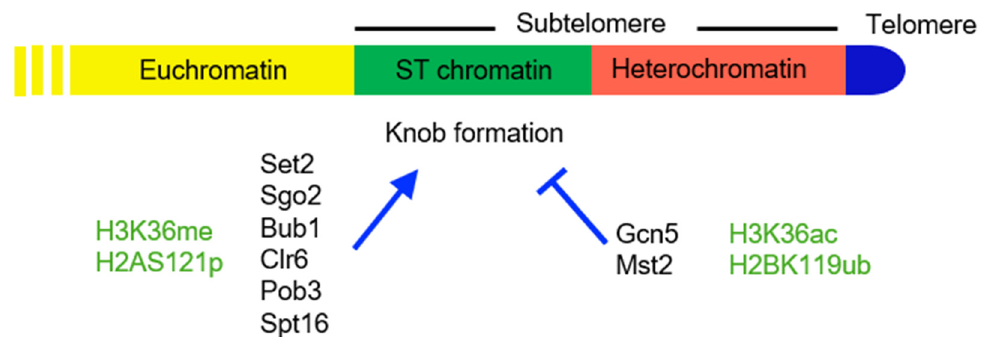
Figure 4. The ST domain in S. pombe. Protein factors (black) and histone modifications (green) that promote (arrowhead) or inhibit (blunt arrow) knob formation are shown below the map [65,79,94].